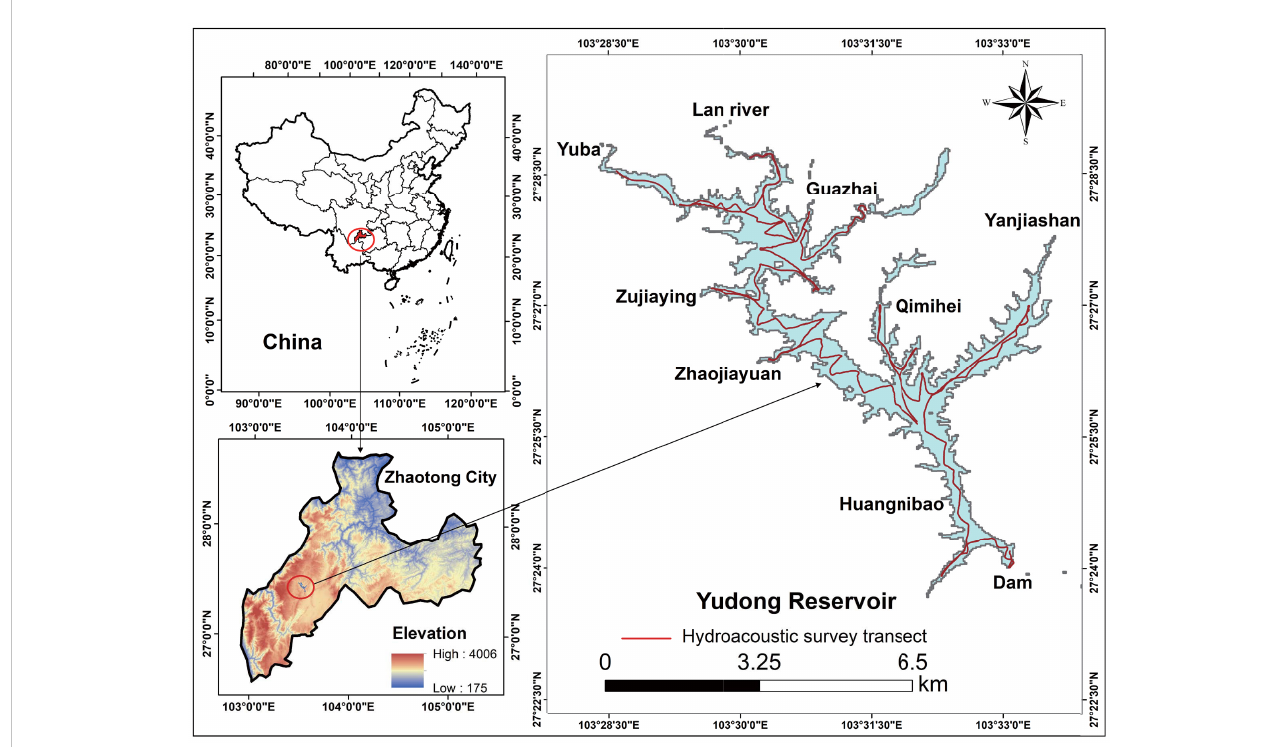
FIGURE 1 Map of the Yudong Reservoir showing its geographical location and hydroacoustic survey